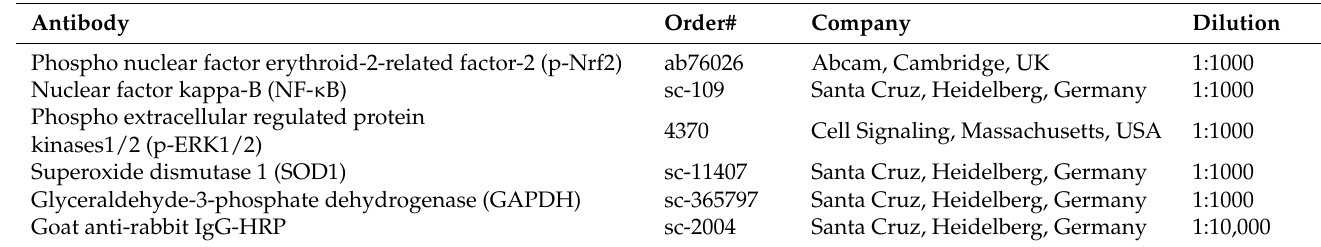
Table 3. The antibodies used for Western